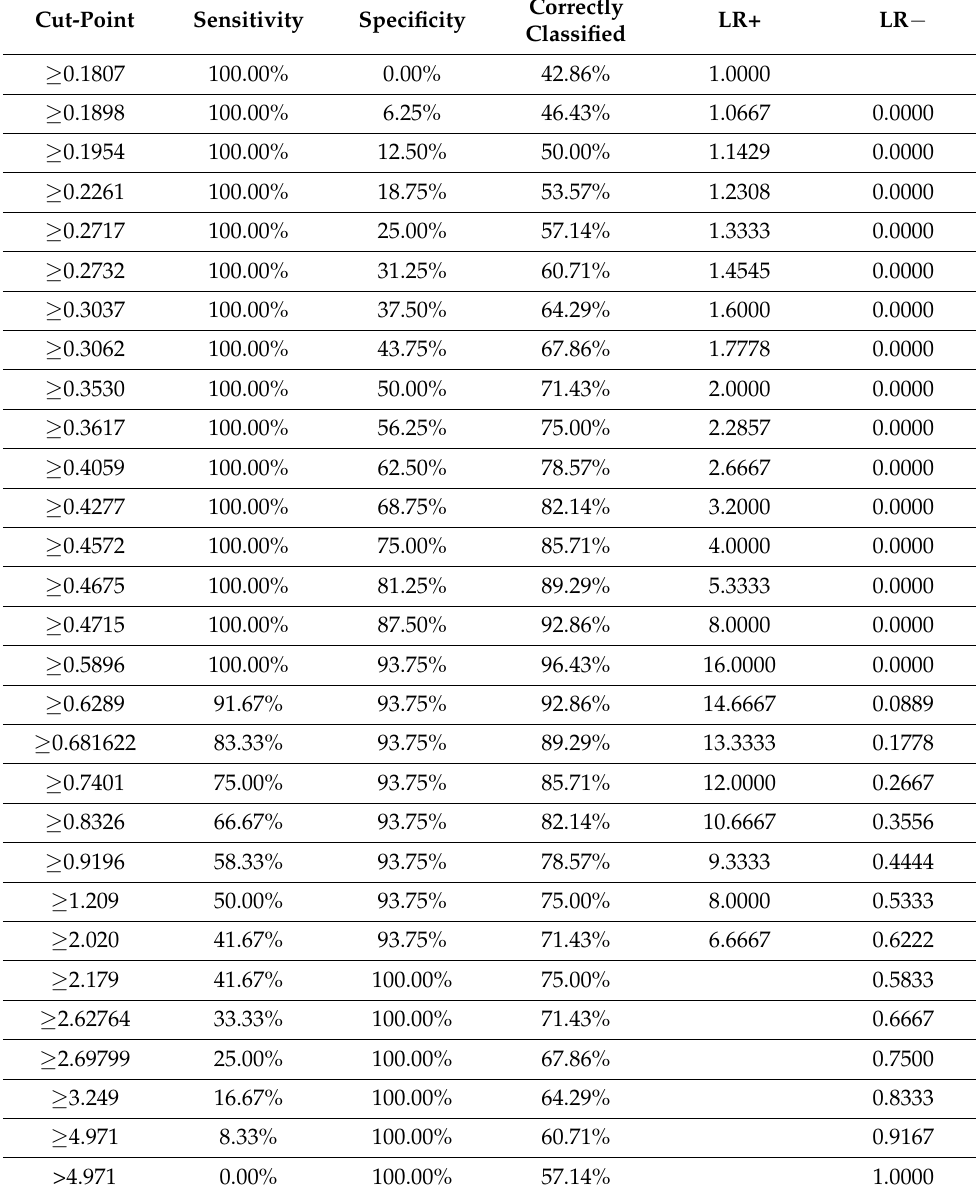
Table 4. Sensitivity and specificity report for different HYAL2 gene expression